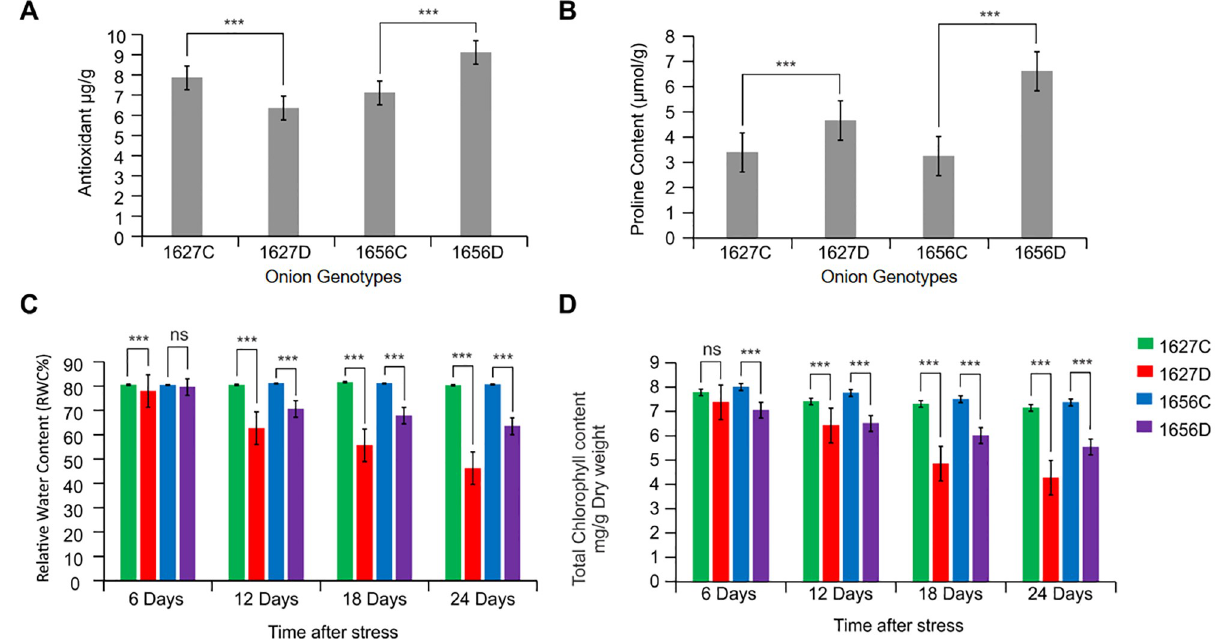
Fig 1. Differential physiological and biochemical response in drought sensitive (1627) and tolerant (1656) onion genotypes. A. Total antioxidant, B. Proline content, C. Relative water content and D. Total chlorophyll content.